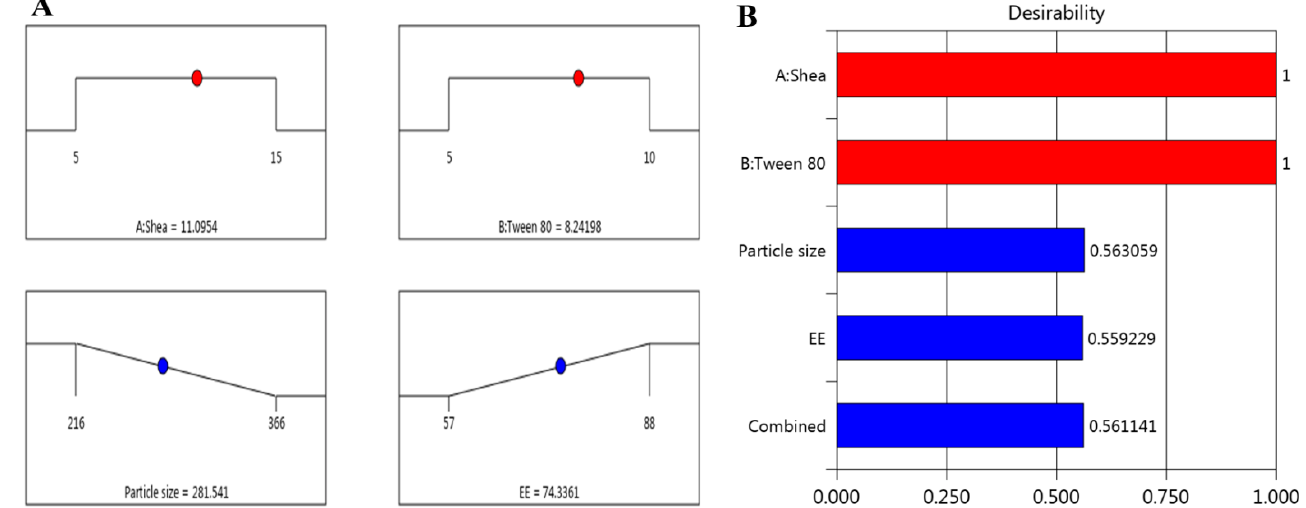
Figure 3. ( A ) Optimization ramps for the independent factors along with the predicted values of responses; ( B ) plot showing the desirability value of all independent factors. Table 2. Predicted versus observed value of the optimized FA-SLN formulation.